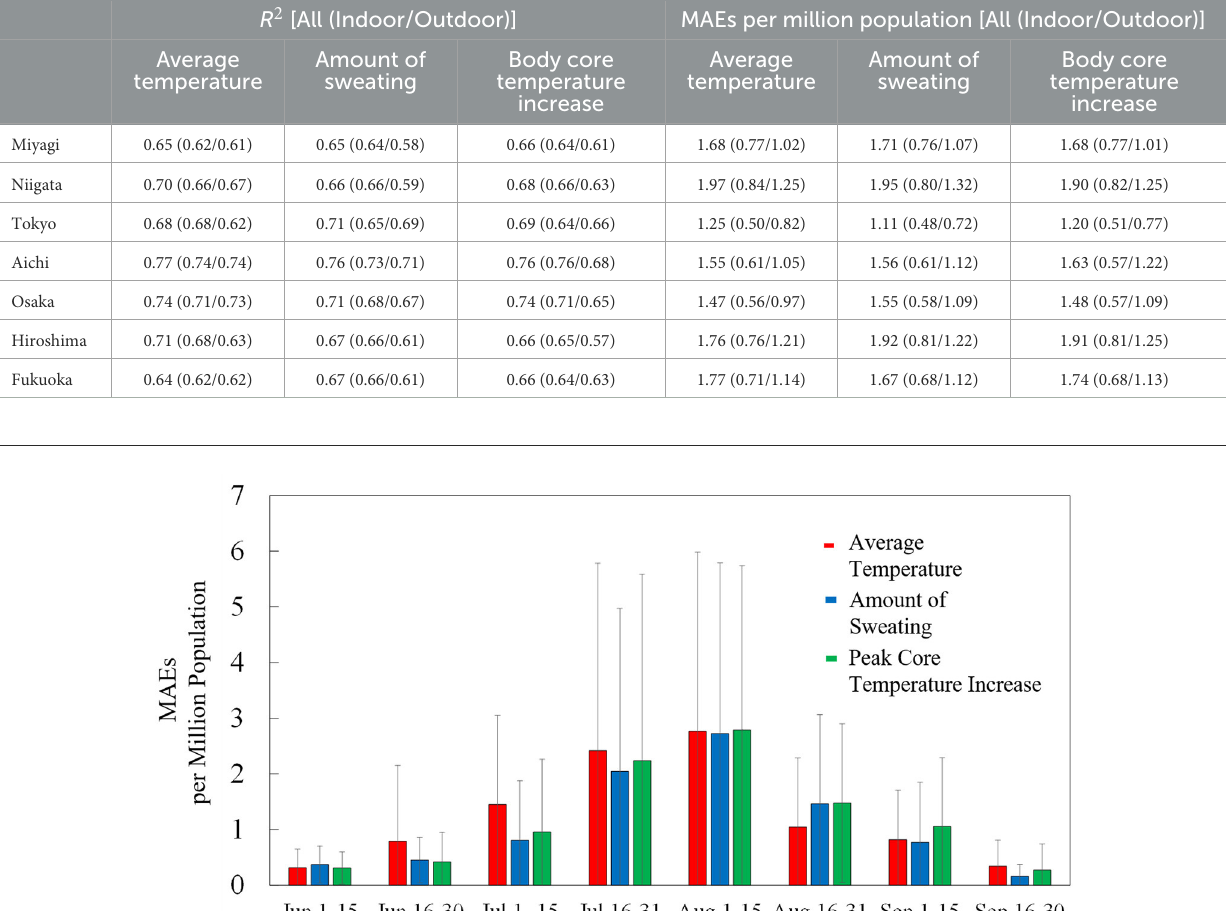
transported patients was overestimated around early July for the average ambient temperature, while from mid-August to mid- September, the amount of sweating and body core temperature